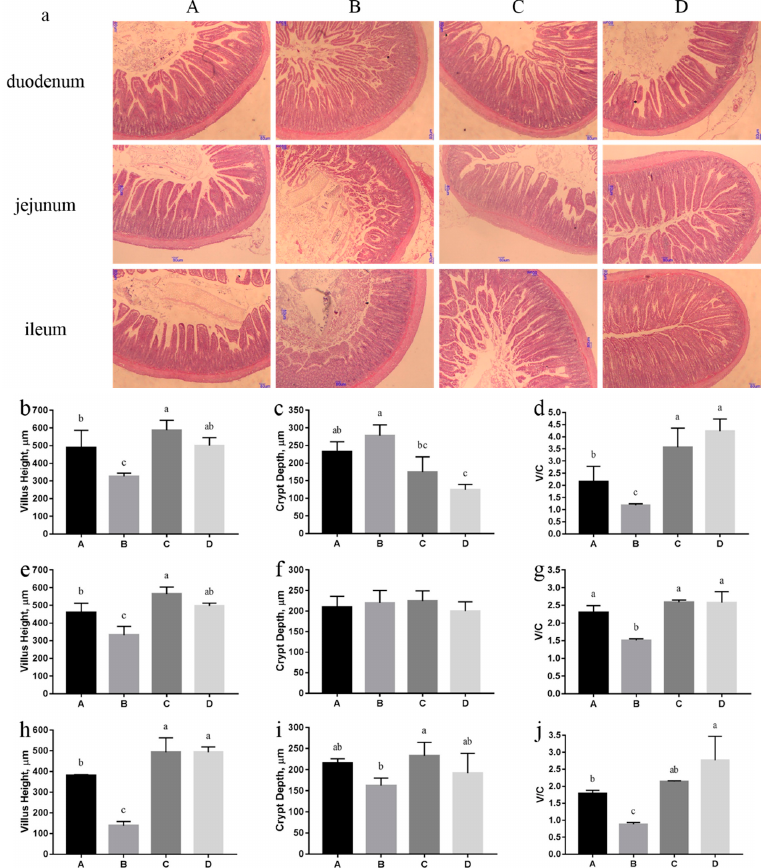
Figure 3. Histomorphology of small intestine between groups ( n = 8 in each group). Note: a,b,c Values without common letters above the histogram differ significantly ( p < 0.05). A: control group with standard diet (0.4% NaCl); B: high-salt diet (4.0% NaCl); C: high-salt diet (4.0% NaCl) with 0.5% betaine; D: high-salt diet (4.0% NaCl) with 1.0% betaine; ( a ): Hematoxylin and eosin (H&E)staining (100×); Duodenum villi height ( b ), crypt depth ( c ) and ratio of villus height to crypt depth (V/C) ( d ); Jejunum villi height ( e ), crypt depth ( f ) and V/C ( g ); Ileum villi height ( h ), crypt depth ( i ) and V/C ( j ).